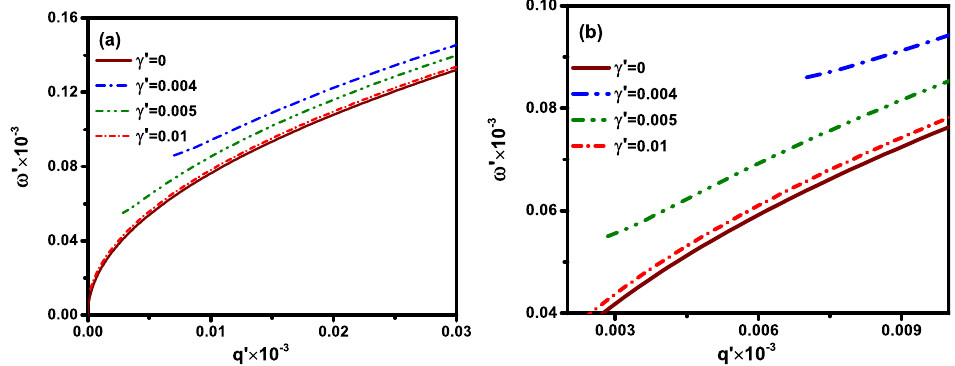
Figure 5. ( a ) TB TM SP for different values of γ (cid:48) . ( b ) The segment of (a) for q (cid:48) × 10 − 3 ≤